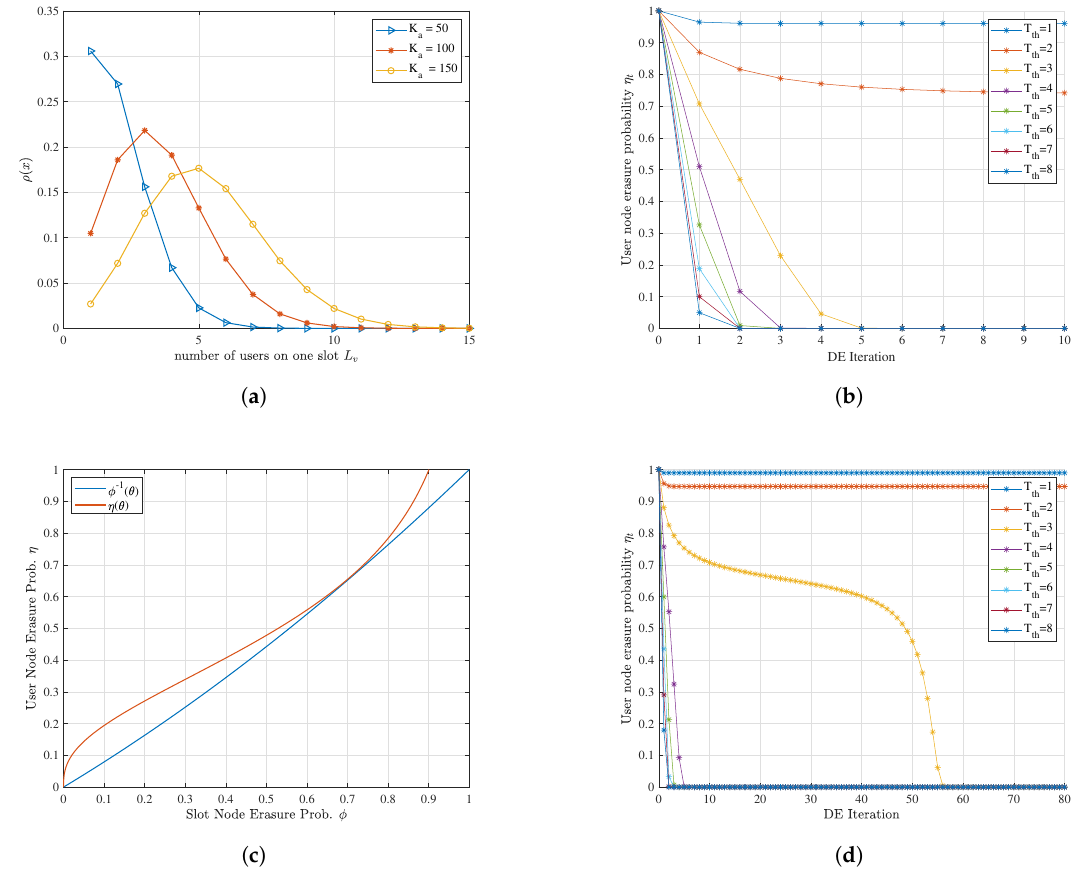
Figure 6. Density evolution analysis of inter-slot code: ( a ) The degree distribution of slot nodes ρ ( x ) at λ ( x ) = 0.5 x 2 + 0.5 x and different users. ( b ) The density evolution procedure at λ ( x ) = 0.5 x 2 + 0.5 x , K a = 100 and V = 28, when T th < 3 it does not converge. ( c ) The density evolution EXIT chart at λ ( x ) = 0.23 x 2 + 0.77 x , K a = 150, V = 28 and T th = 3. The tunnel is about to close, representing the boundary condition. ( d ) Corresponding density evolution iteration procedure at the same configuration with ( c ) but varying T th , where T th = 3 is just able to